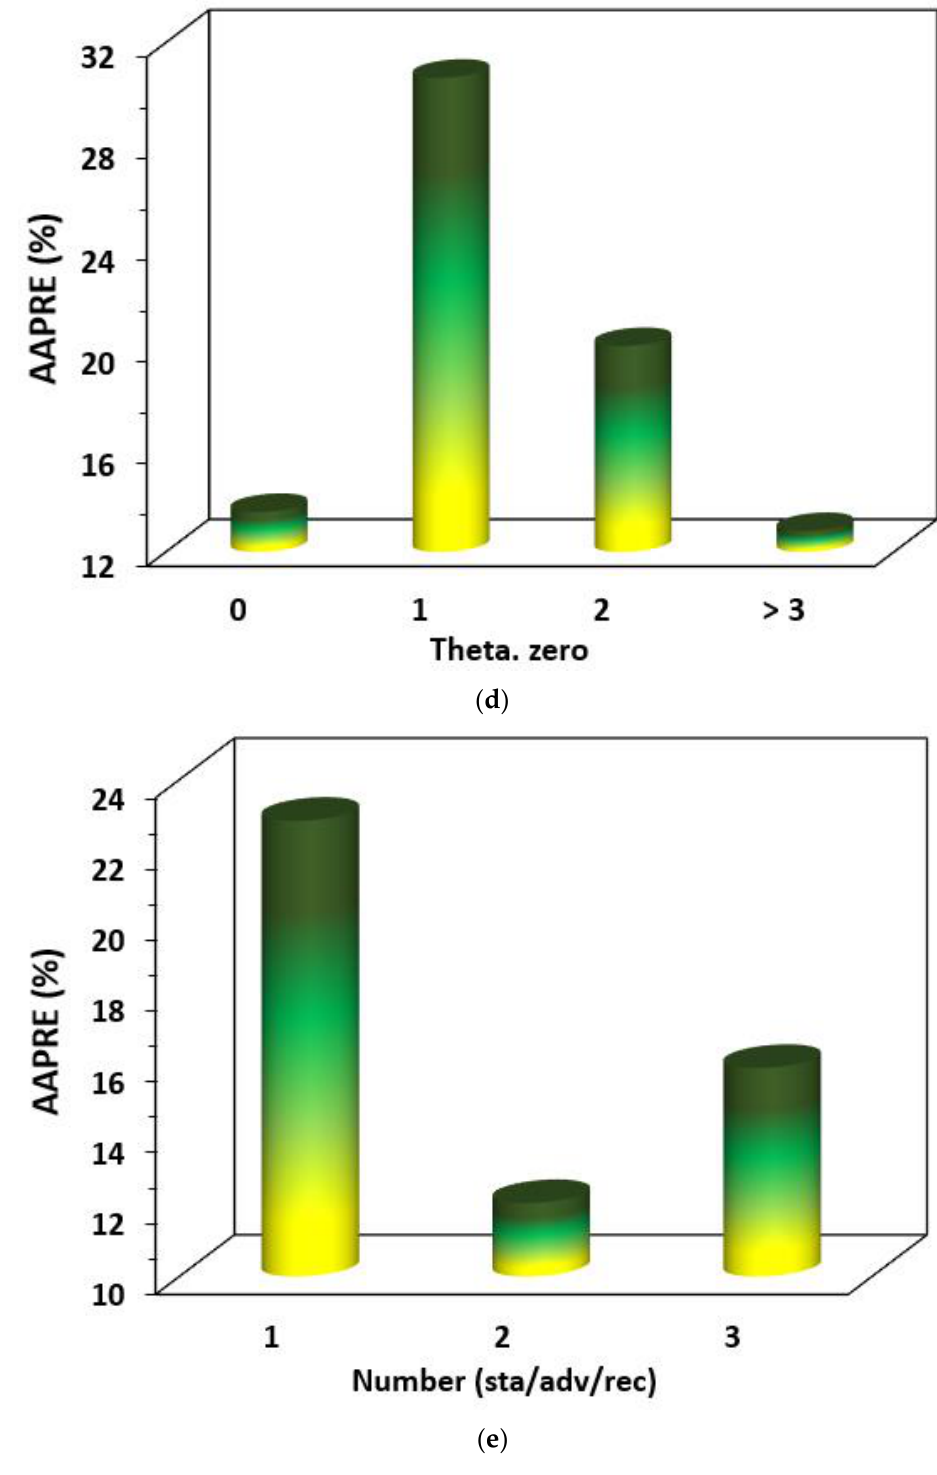
Figure 10. AAPRE for the correlation implemented in this study for different input parameters: ( a ) Pressure, ( b ) Temperature, ( c ) Salinity, ( d ) Theta. Zero, and ( e ) Contact angle type.